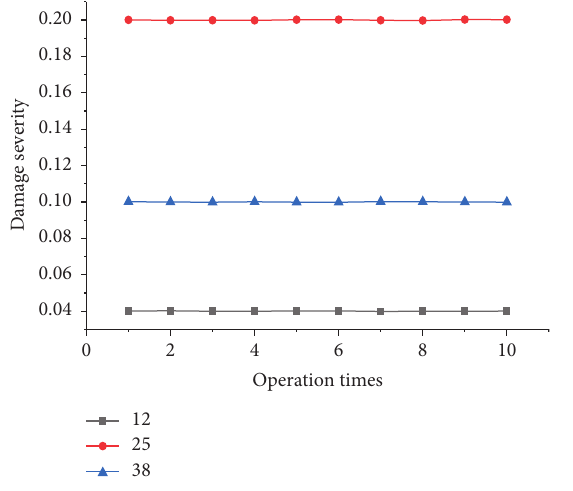
Figure 6: Damage severity identification of GA.